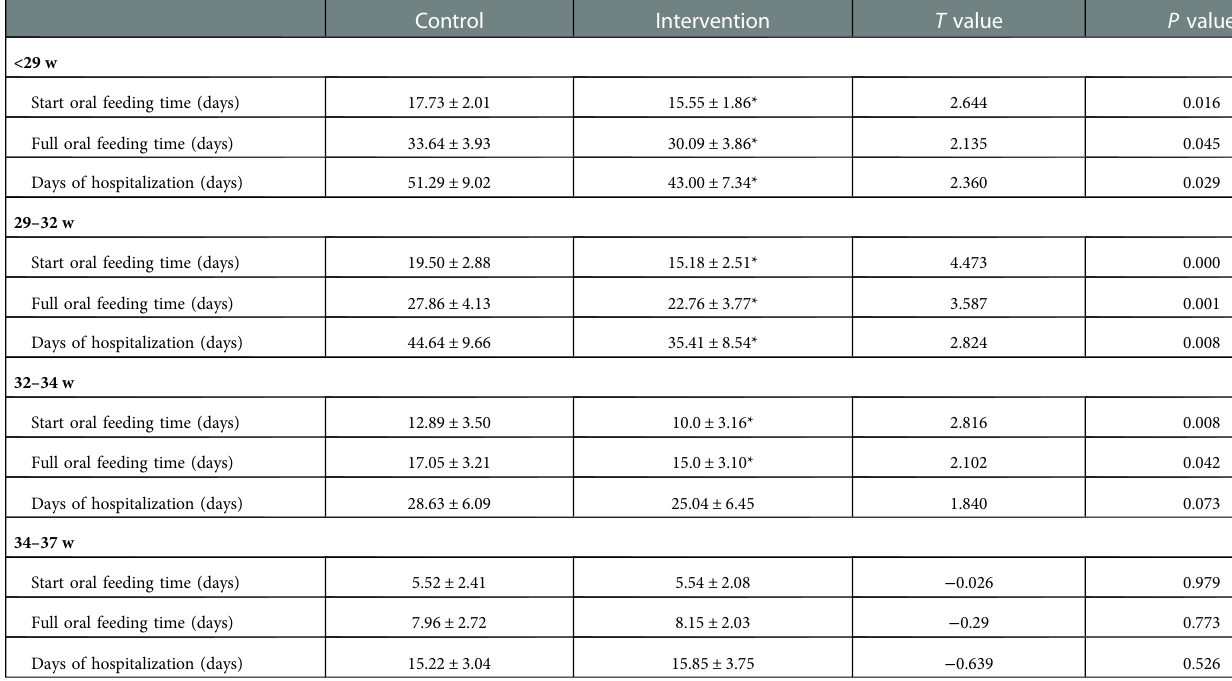
TABLE 2 Comparison of feeding process and hospitalization days between intervention group and control group of preterm infants with different gestational ages ( (cid:1) X + s